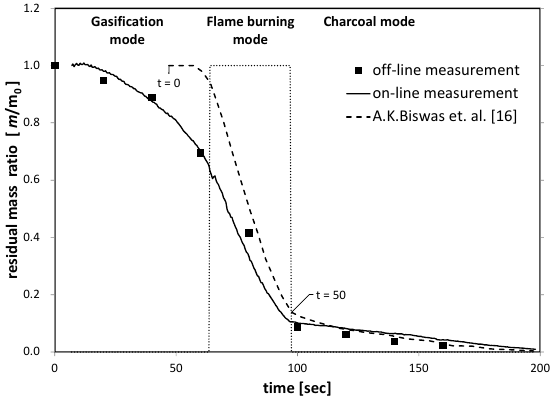
Figure 12. Wood pellet density measurement results and data fitting for mass calculation of wood pellet at each time.